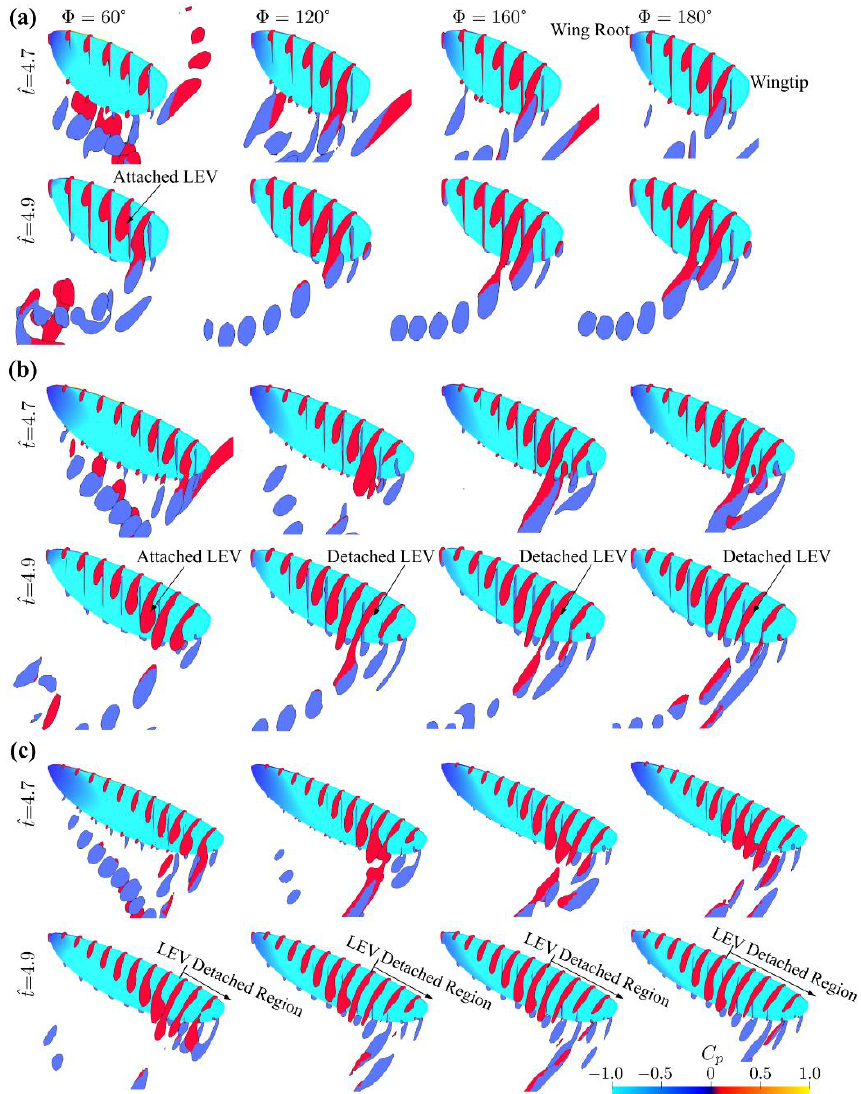
Figure 9. Flow structures for the different stroke amplitudes for ( a ) 𝐴𝑅 = 3, ( b ) 𝐴𝑅 = 4.5, and ( c ) 𝐴𝑅 = 6. ( c ) AR =